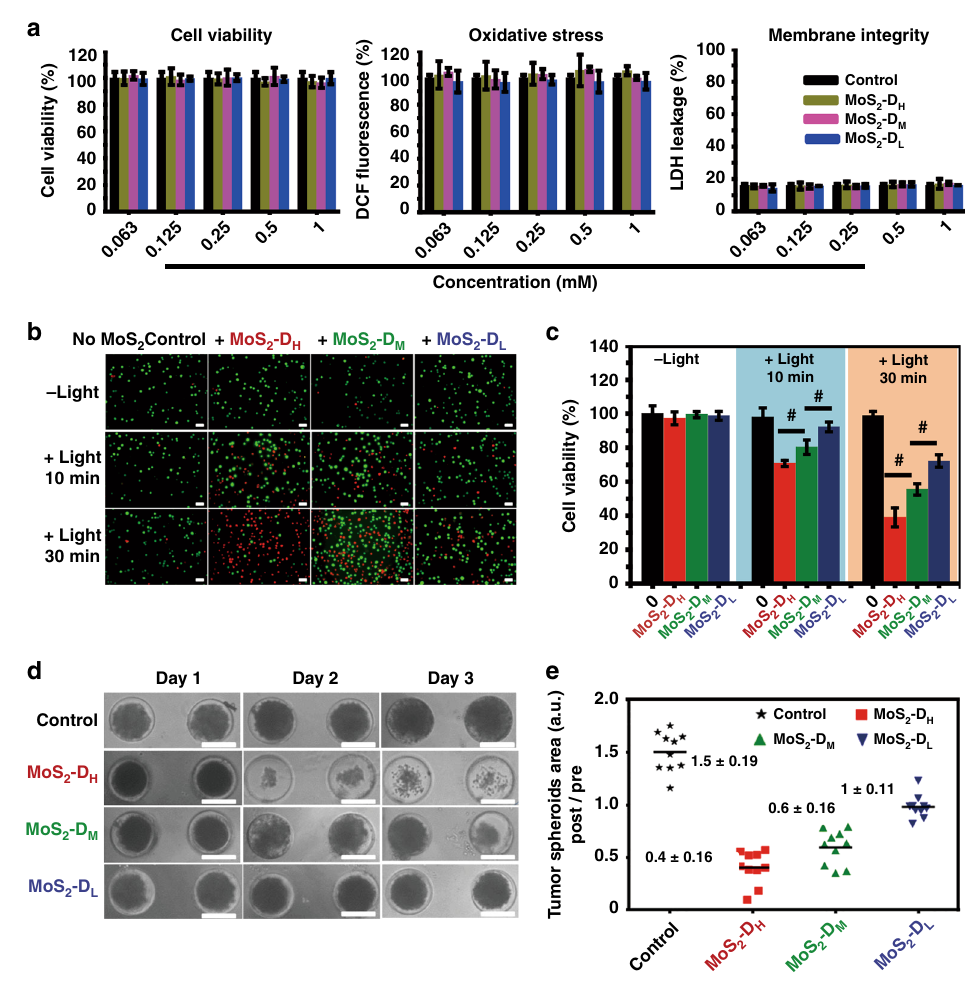
Fig. 7 MoS 2 QDs with more S defects produce more oxidative stress in cancer cells. a MoS 2 QDs treatment (without light) on human endothelial cells (HMVEC) showed negligible cytotoxicity, negligible excessive ROS generation and low apoptosis induction. The measurements were performed in triplicate. b Calcein AM and PI co-staining and c cell viabilities of SW480 cells incubated with different defect laden MoS 2 QDs under white light exposure. The measurements were performed in triplicate. d MoS 2 -D H showed the highest size reduction of 3D tumor spheroids assay. This implied high penetration of QDs into the interior of the 3D tumor spheroids mass with the highest defect group producing the highest oxidative stress that killed the cells. e Quanti fi cation of 3D tumor spheroids area post treatment and laser excitation with MoS 2 -D H showing the greatest cell death amongst the three MoS 2 groups. Mean ± SD, n = 10, Student ’ s t test, p # < 0.05. Scale bar: 100 μ